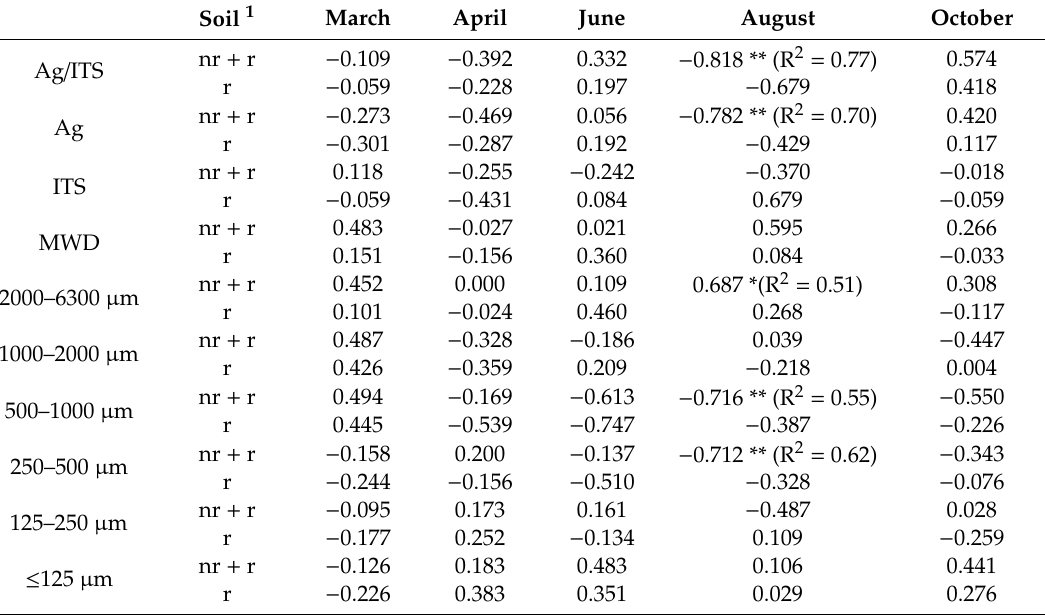
Table 4. Spearman’s rank correlation coe ffi cient ( ρ s) among cross-sectional areas (CSA), soil fungal parameters, MWD and mass distributions of sieve-size